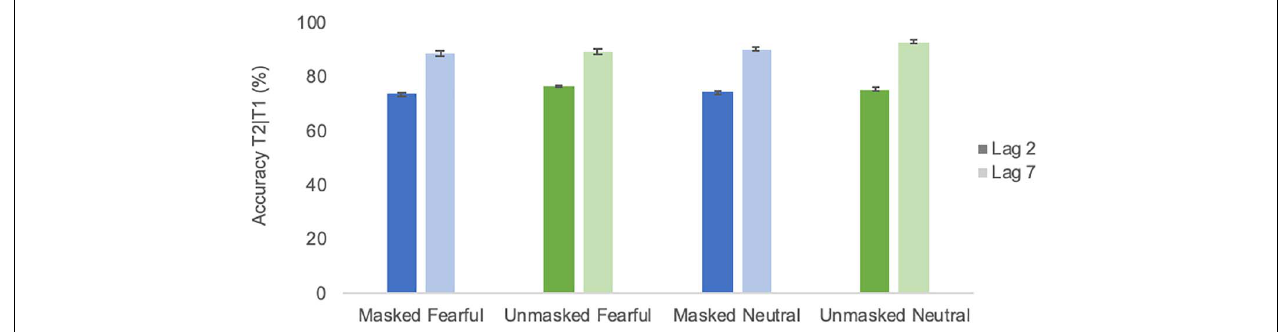
FIGURE 7 | Average identification accuracy of T2 in different emotional conditions of Experiment 2. Error bars represent one standard error of the mean.